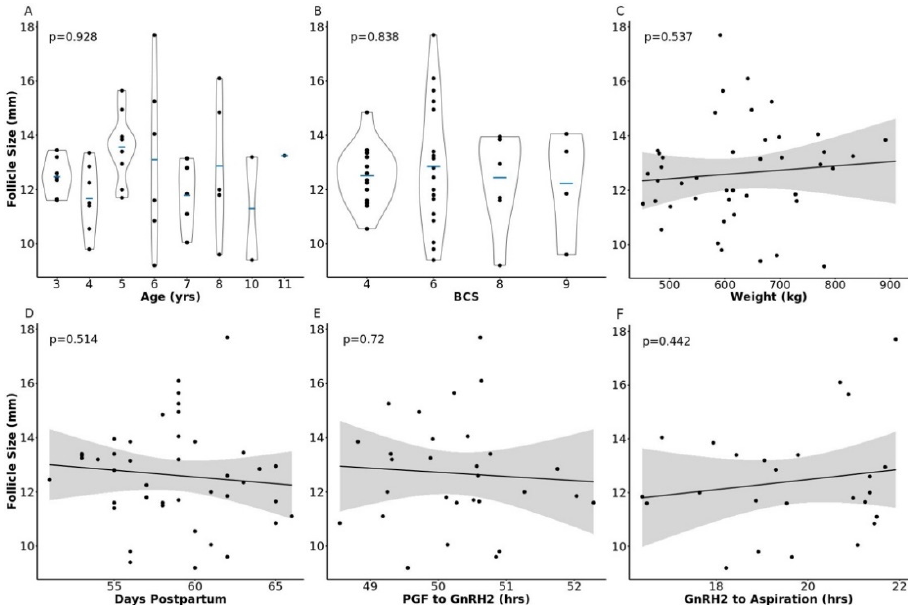
Figure 1. Relationship between pre-ovulatory follicle diameter and cow phenotype or timeline parameters. Panels ( A – F ) depict the relationship between follicle size at gonadotropin-releasing hormone administration to induce a pre-ovulatory gonadotropin surge (GnRH2) and cow age, body condition score (BCS), weight, days postpartum, hours from prostaglandin F2 α administration (PGF) to GnRH2 administration, and hours from GnRH2 administration to follicle aspiration, respectively.